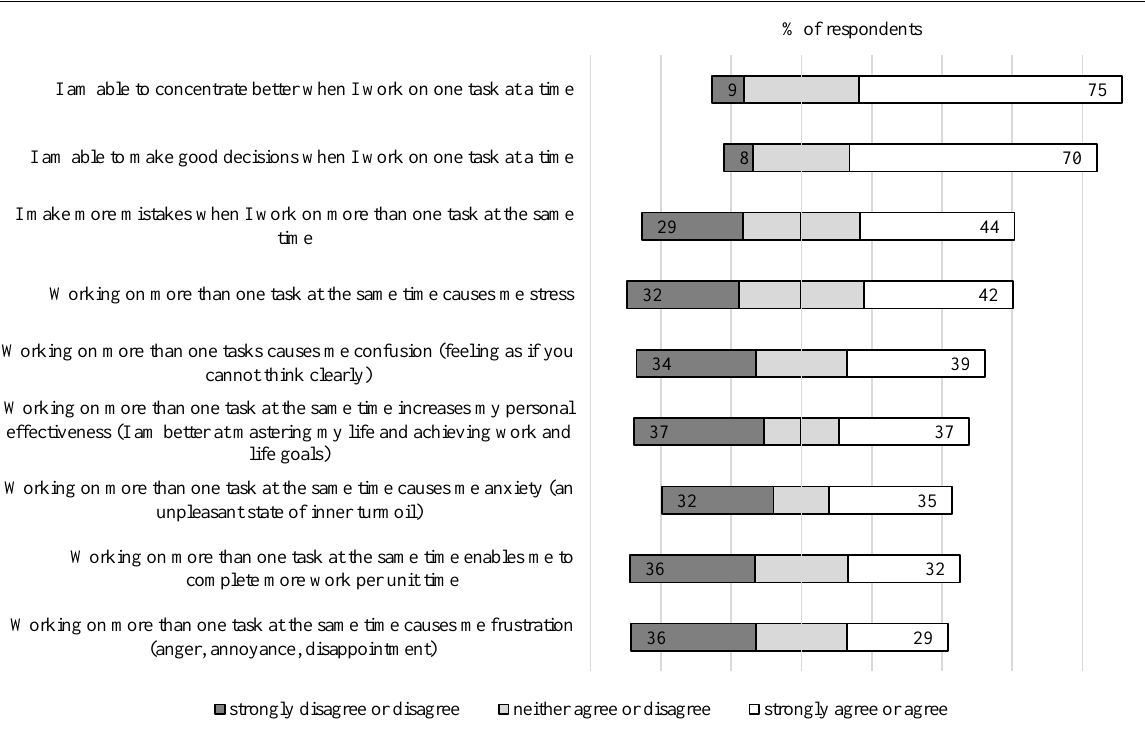
Figure 2. Perception of the positive and negative effects of multitasking at the level of an individual. 4-4- Multitasking and Individual Time Management Orientation